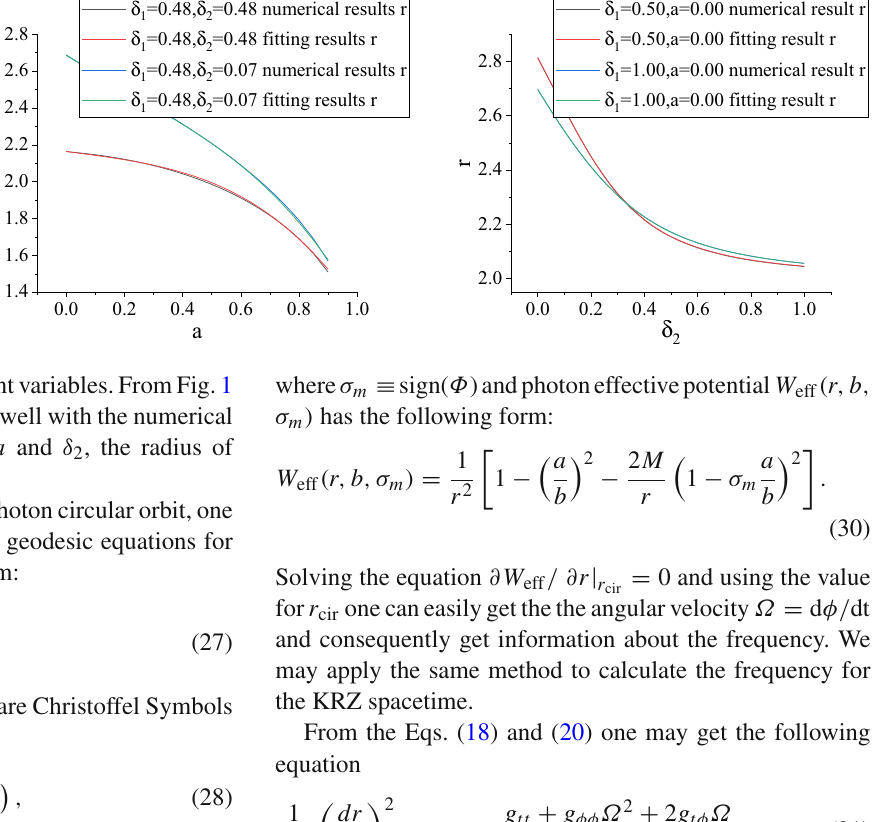
Fig. 1 Comparison of numerical and fitting results for the radius of photon orbit depending on the spin a (left panel) and the δ 2 (right panel) parameters for different values of a , δ 1 and δ 2 . Note the plane we choose is the equatorial one i.e. θ = π/